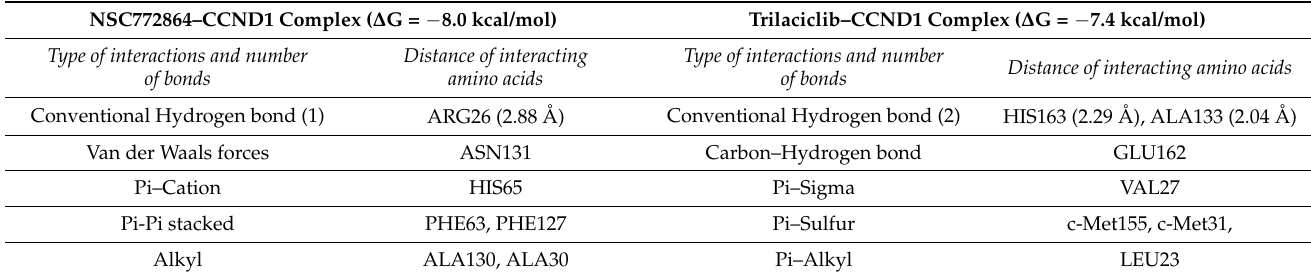
Table 6. NSC772864 and standard drug comparative docking profiles against